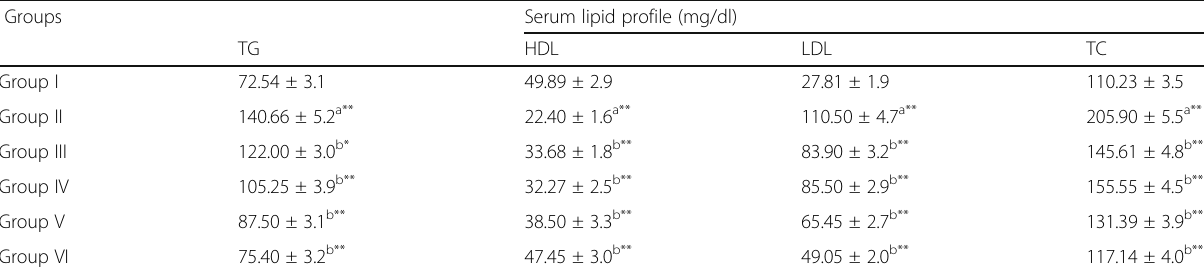
All values were expressed as mean±S.E.M ( n= 3). (*) indicates statistically significant difference from the respective group ( ** p <0.01) using ANOVA, followed by Dunnett ’ s multiple comparison test. a=when compared with healthy control, b=when compared with diabetic control. Group I =Healthy control, Group II = Diabetic control, Group III =Diabetic control +10mg/kg of gliclazide, Group IV =Diabetic control +100mg/kg CRME, Group V =Diabetic control +200mg/kg CRME, Group VI =Diabetic control +400mg/kg